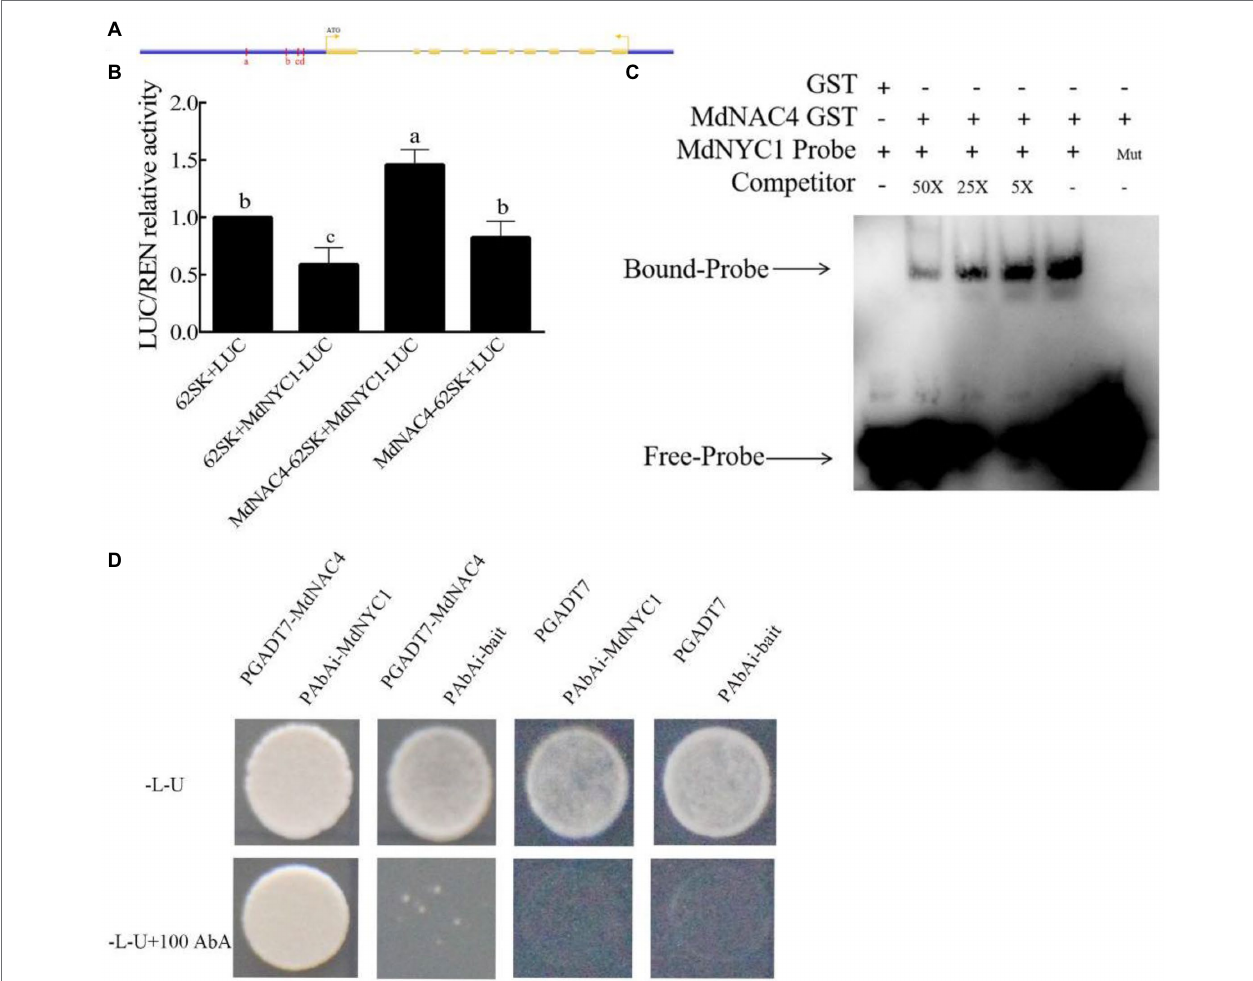
FIGURE 3 | MdNAC4 activated the expression of MdNYC1 . (A) Diagram of the MdNYC1 gene promoter region. a-d, represent the potential sites to which MdNAC4 might bind. (B) Transient expression assay of tobacco leaves showing that MdNAC4 activated the expression of MdNYC1 . (C) EMSA showing that the MdNAC4-GST fusion protein was bound to the MdNYC1 promoter. Unlabeled probes were used as competitors, with “Mut” representing the mutated probe in which the 5’-ACGTG-3 ′ motif was replaced by 5’-CCGTC-3 ′ . (D) Y1H assay revealing the interaction between MdNAC4 and the MdNYC1 promoter. The data are expressed as the means ± SDs ( n = 3). The significance of the differences was tested by one-way ANOVA; p <